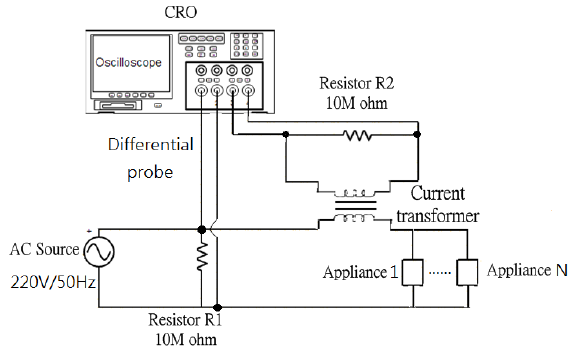
Figure 4. Measurement set up for capturing voltage and current waveforms of electric appliances. CRO, cathode ray oscilloscope.